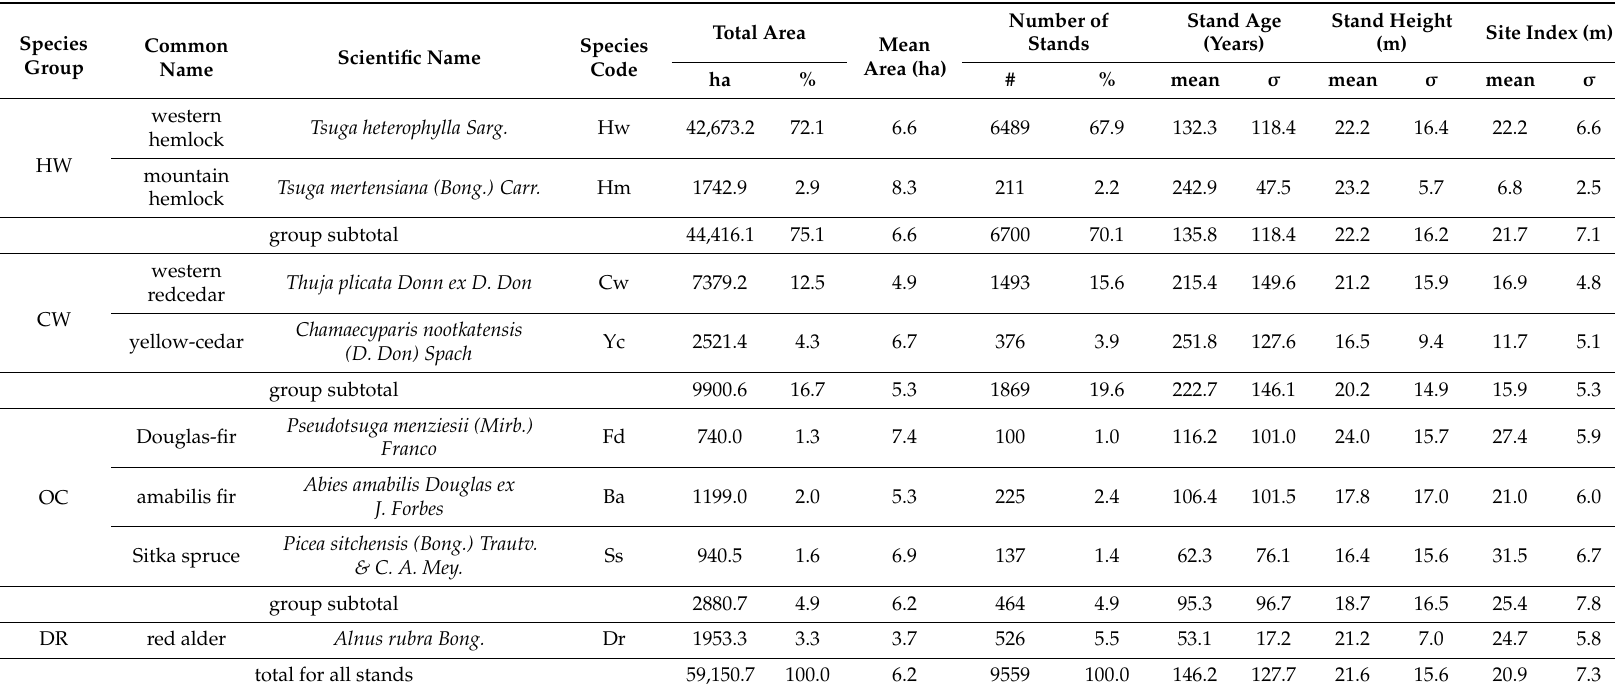
Table 1. Forest stand characteristics in the study